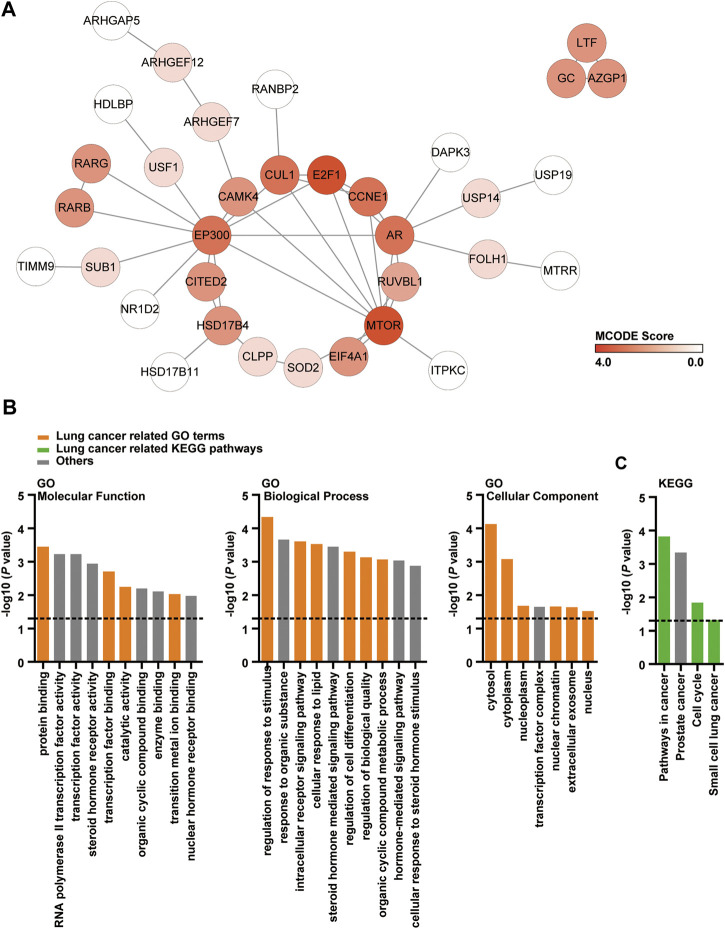
PPI, GO and KEGG analysis of DMDD potential target proteins. (A) PPI network of 60 DMDD potential targets which consists of 59 nodes and 47 edges. The node color changes from light to dark red in according to the MCODE score. (B, C) Cellular component, molecular function, biological process, and KEGG analysis of 60 DMDD potential target proteins.